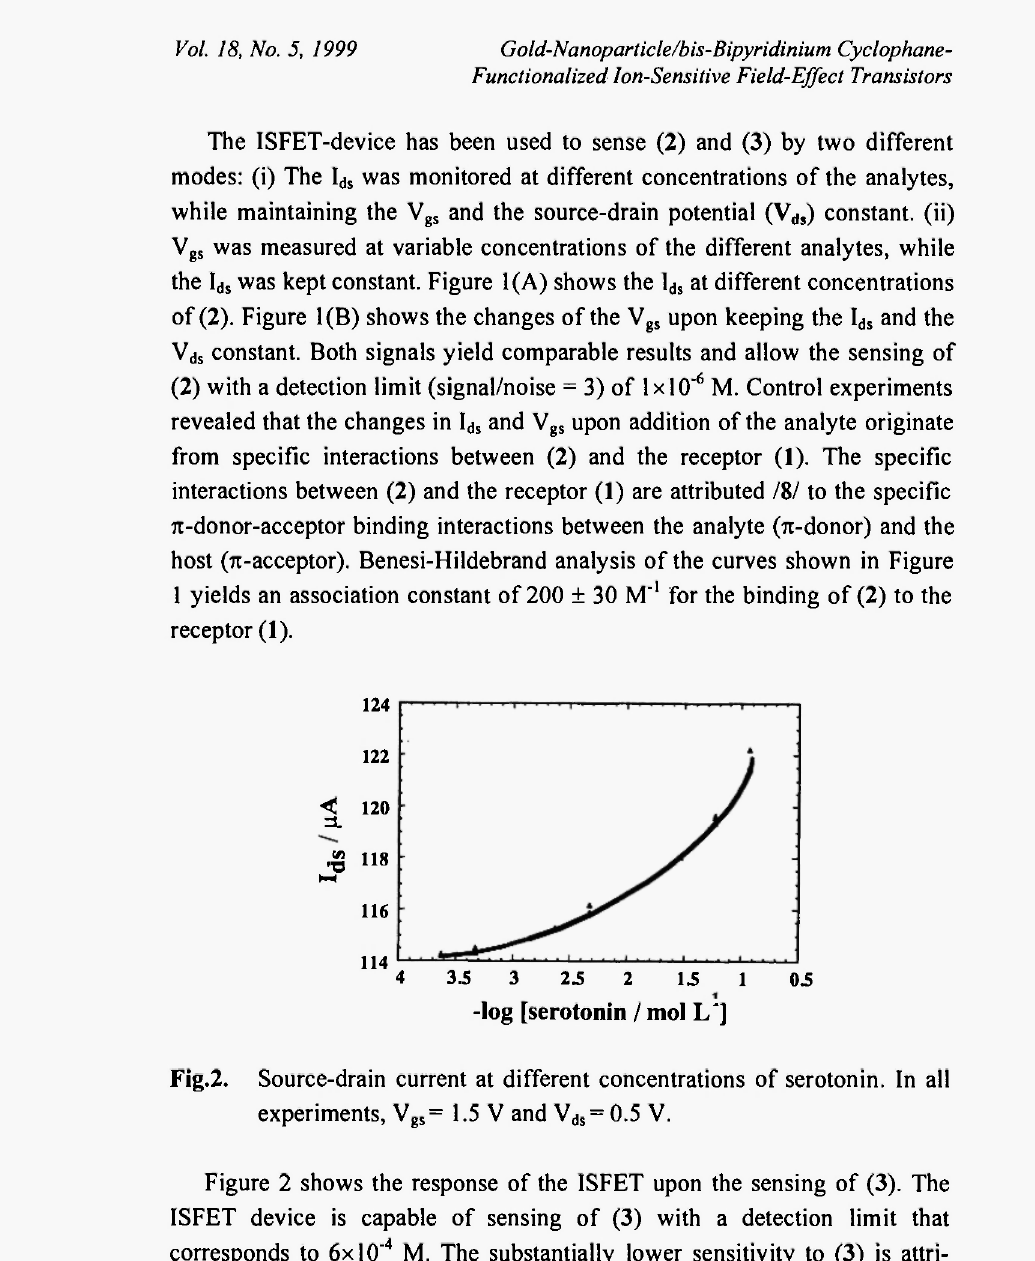
Fig.2. Source-drain current at different concentrations of serotonin. In all experiments, V gs = 1.5 V and V ds = 0.5